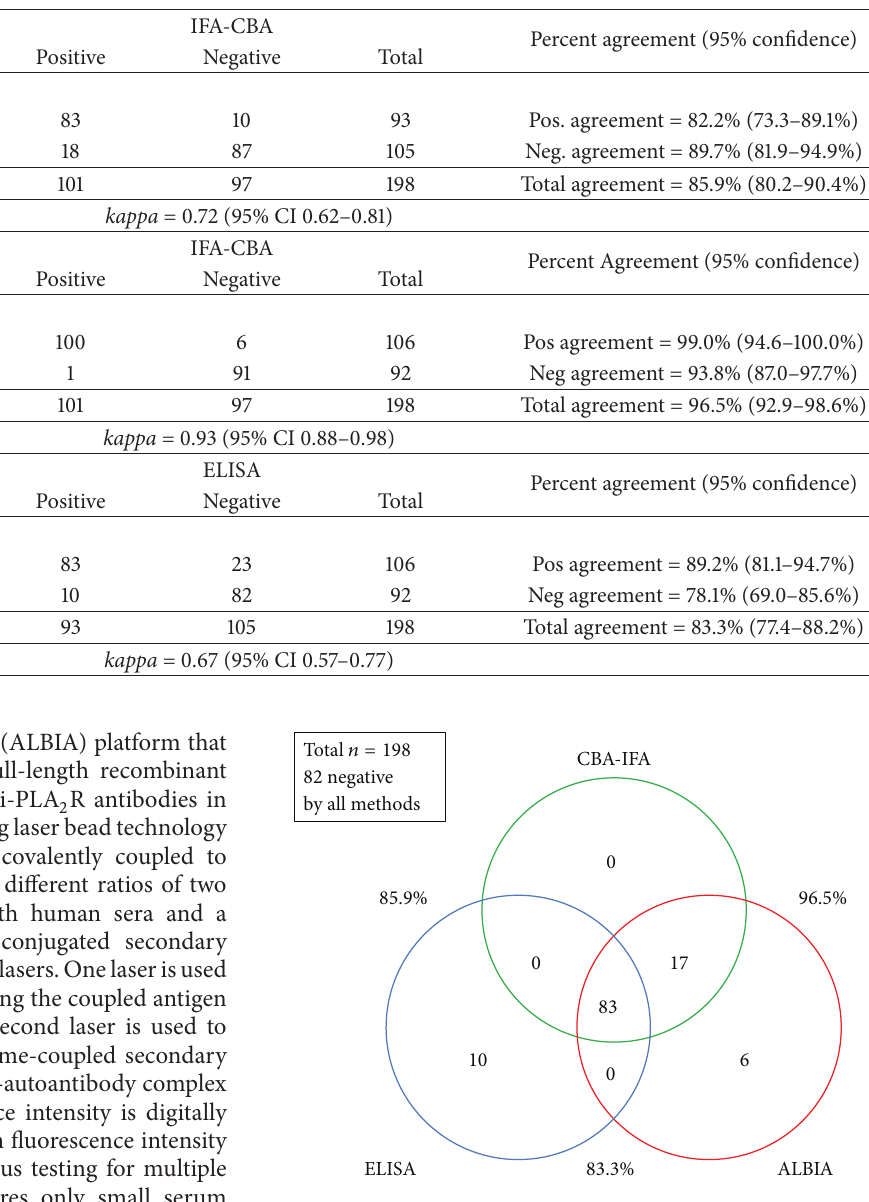
Figure 1: Correlation between different diagnostic immunoassays for the detection of anti-PLA 2 R antibodies. In our cohort of 157 IMN patients and 41 nephrotic disease control patients, a total of 83 samples were positive and 82 were negative by all three methods, a concordance of 77.6% for all three methods. Overall qualitative agreements were 85.9% for CBA-IFA versus ELISA, 96.5% for CBA- IFA versus ALBIA, and 83.3% for ELISA versus